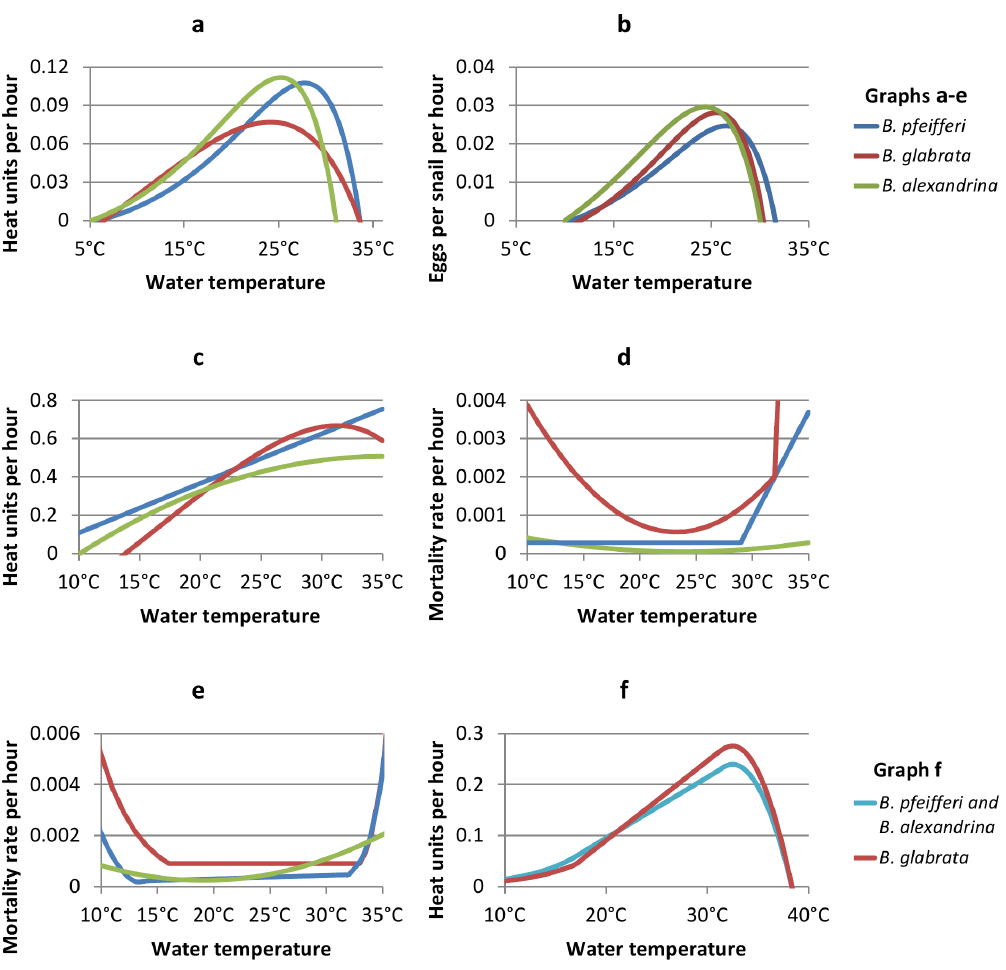
Figure 2. Comparison of parameters used in models of B.pfeifferi , B.glabrata and B.alexandrina . a) Juvenile development. Heat units gained per hour. Snails become adults and start producing eggs once they have gained 100 heat units. b) Egg production. Eggs per snail per hour. c) Egg development. Heat units gained per hour. Egg hatch once they have gained 100 heat units. d) Egg mortality rate per hour. e) Uninfected and prepatent snail mortality rate per hour. f) Parasite development within the snail. Heat units gained per hour. Snails become infectious once they have gained 100 heat units. Blue lines show parameters for B. pfeifferi , red for B. glabrata , green for B. alexandrina , and turquoise for both B. pfeifferi and B. alexandrina